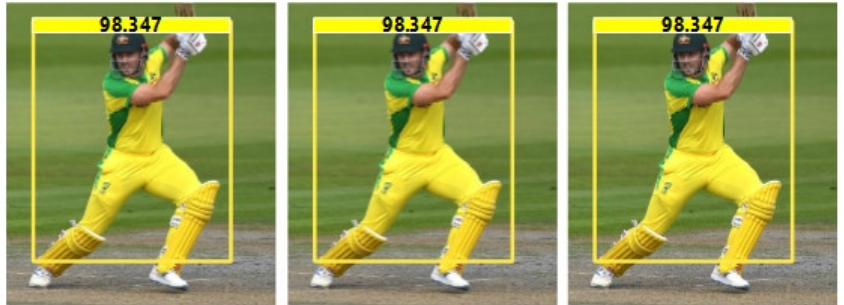
Figure 6. The resized frame of 137 × 197 dimension.